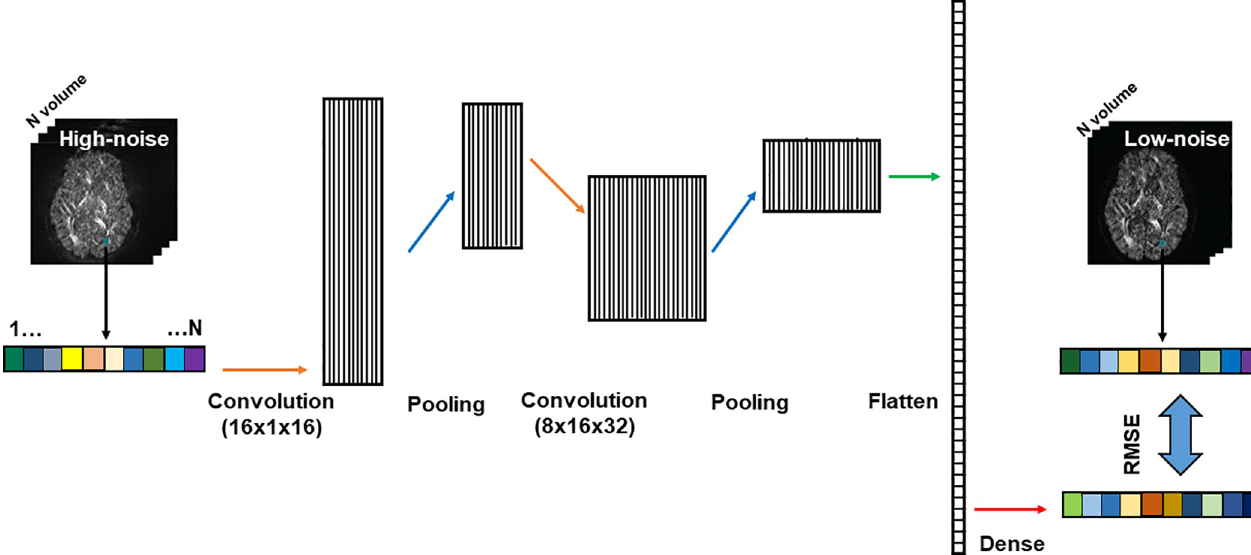
Fig 1. Schematic drawing of the architecture of the 1D CNN model for denoising. “16x1x16” means the dimension of convolutional operation: kernel size = 16, depth = 1, number of filters = 16.